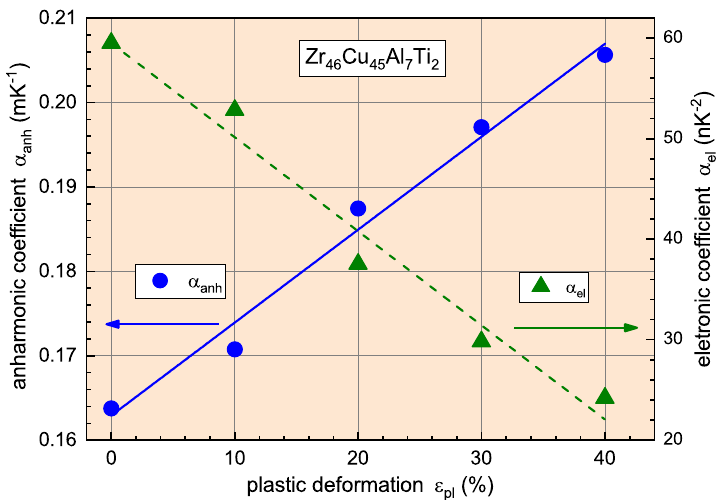
Figure 5. Dependence of the anharmonic coefficient α anh and electronic coefficient α el defined by Equation (1) on plastic deformation ε pl . The solid lines give least-square-fits of the data points. The errors are about the symbols’